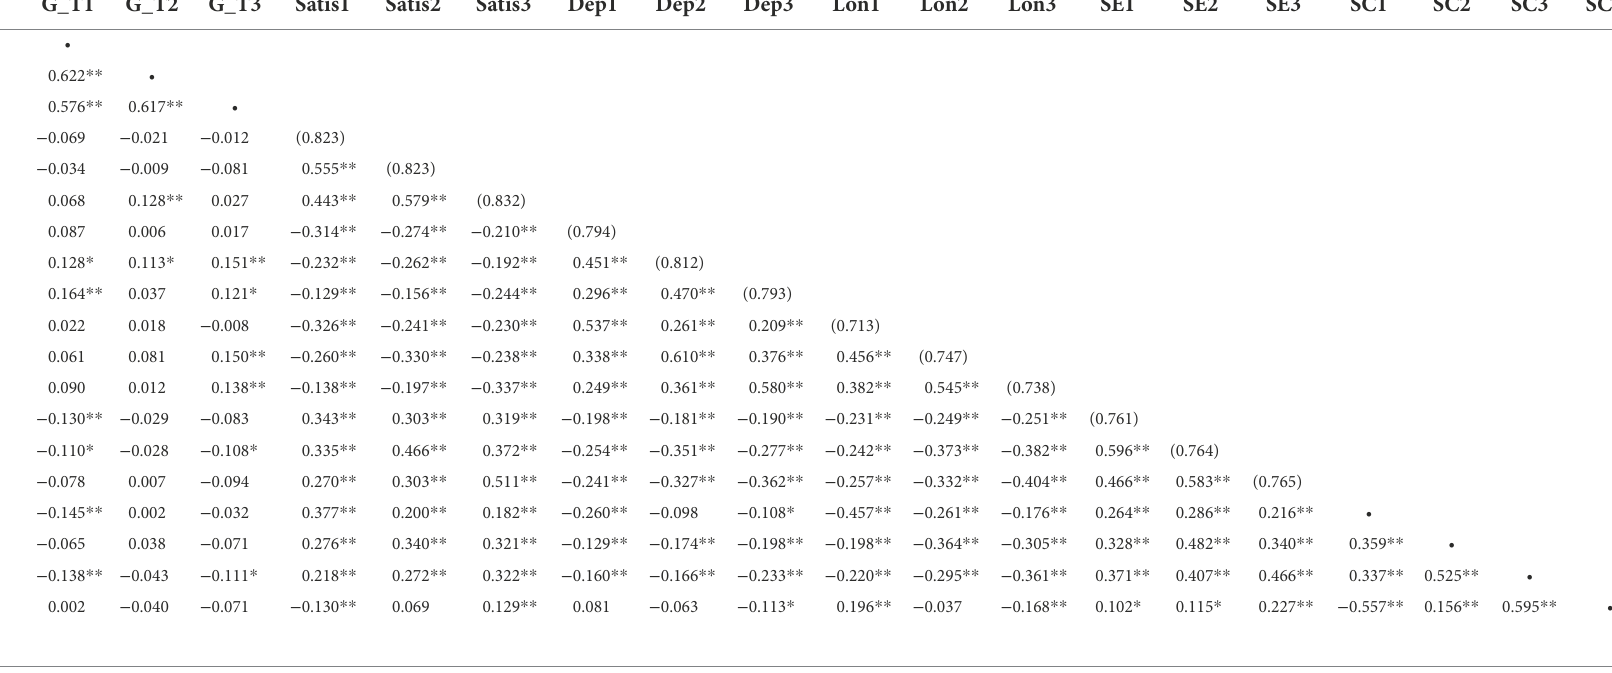
TABLE 2 Correlations and discriminant validity